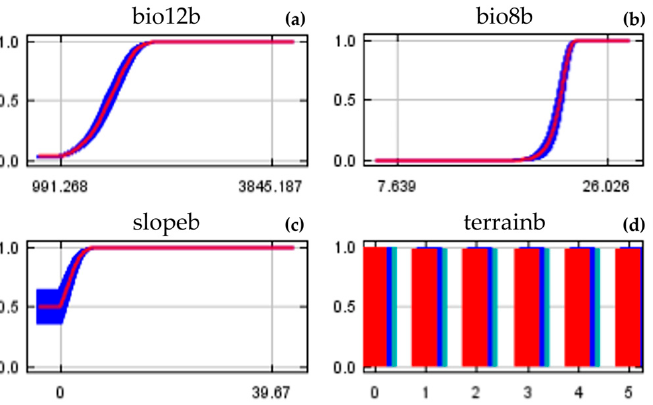
Figure A4. The response curve of Q. acuta ’s dominant environmental factors. ( a ) indicates that of bio12; ( b ) indicates that of bio8; ( c ) indicates that of slope; ( d ) indicates that of terrain. Red curves show the mean response of the 10 replicate Maxent runs and blue margins (two shades for categorical variables) indicate ± 1 standard deviation.